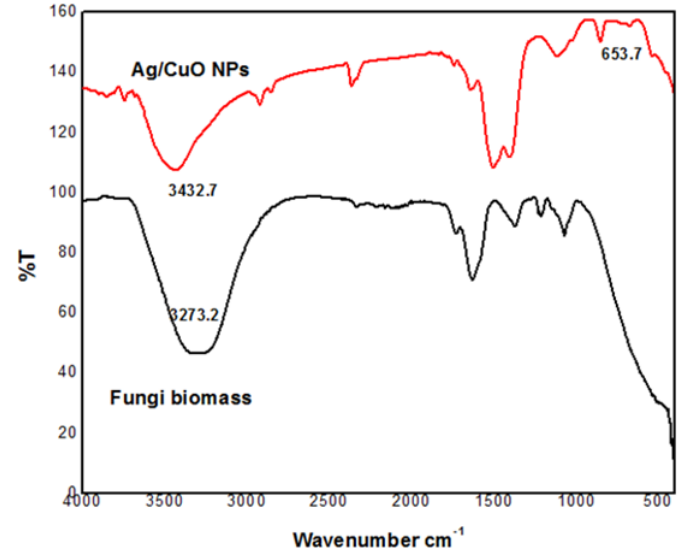
Figure 6. FT-IR spectra of synthesized Ag/Cu NPs.